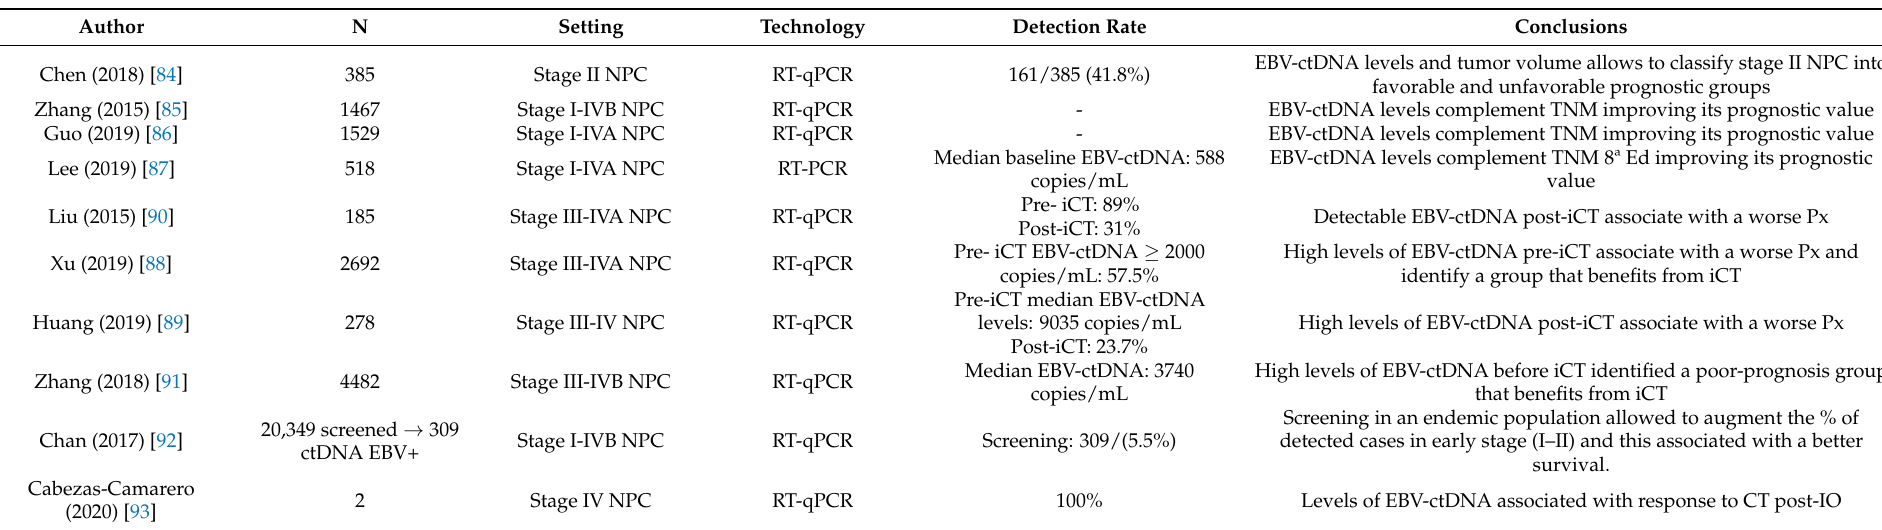
Table 5. Most relevant studies with ctDNA in patients with EBV+